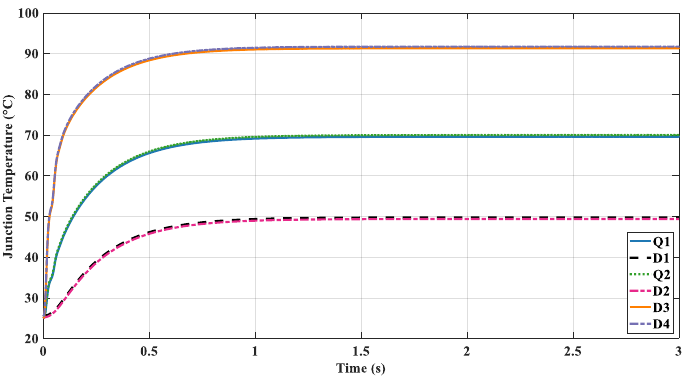
Figure 13. The junction temperature of the power semiconductors within the floating-interleaved boost converter.